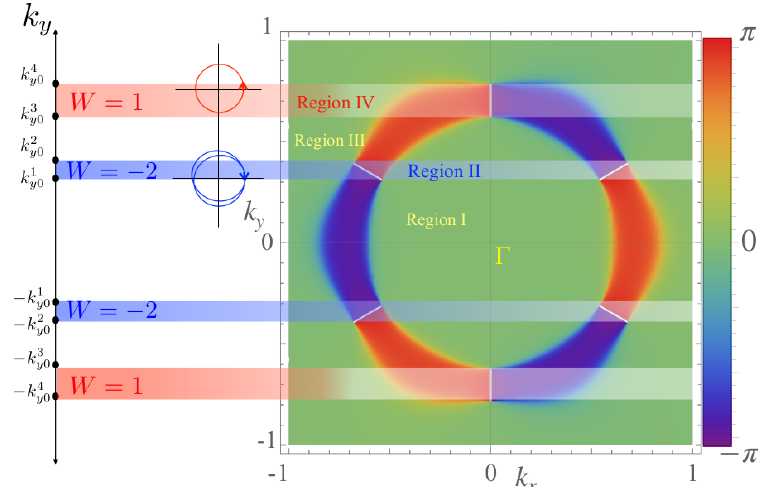
Figure 3: Phase diagram of the family of 1D chiral Hamiltonians as a function of the transverse momentum parameter k . The parameter range between the nodal points y ( 1 ) ( 3 ) < k < k ( 2 ) < k < k ( 4 ) k and k corresponds to a topologically non-trivial phase y y y 0 y 0 y 0 y 0 with a topological invariant of W = − 2 and W = 1, respectively. The winding W of the phase of the determinant of the matrix, Eq. (6) accumulated as k Q over the Brillouin Zone is presented for the different values of k